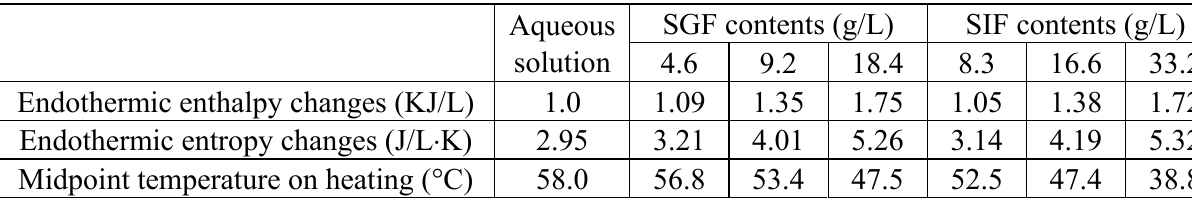
Table 7. Thermal characteristics of HPMC thermograms for 10 wt% HPMC solutions with various SGF and SIF